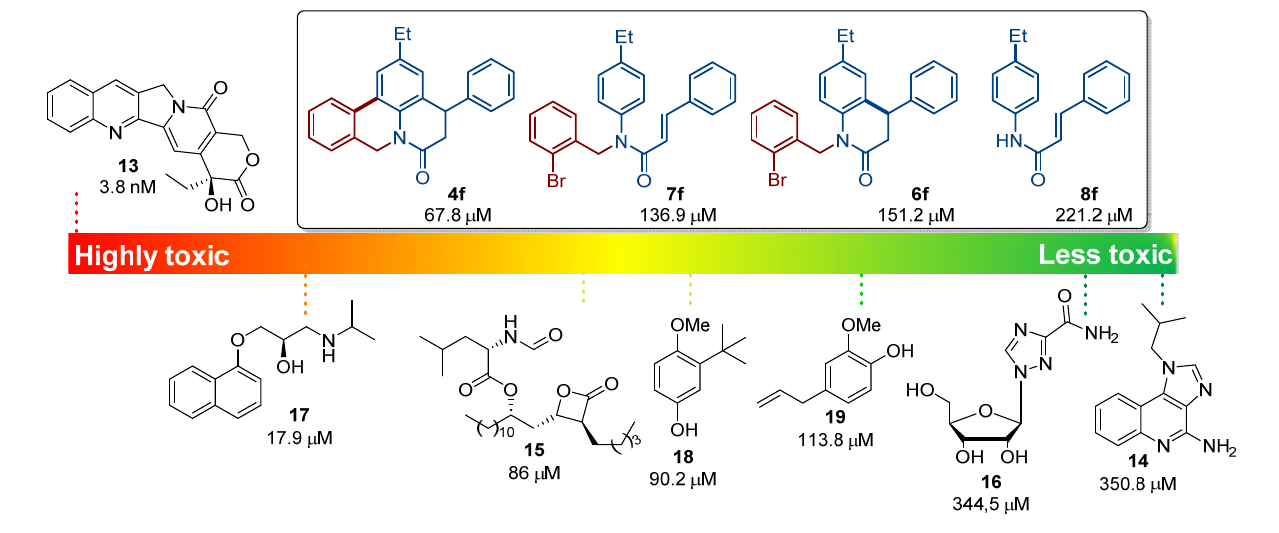
Figure 5. Toxicity scale established with the selected drugs 13 – 19 and toxicological profile of the selected pyridophenanthridin ‐ 6 ‐ one 4f and its corresponding precursors 6f – 8f .